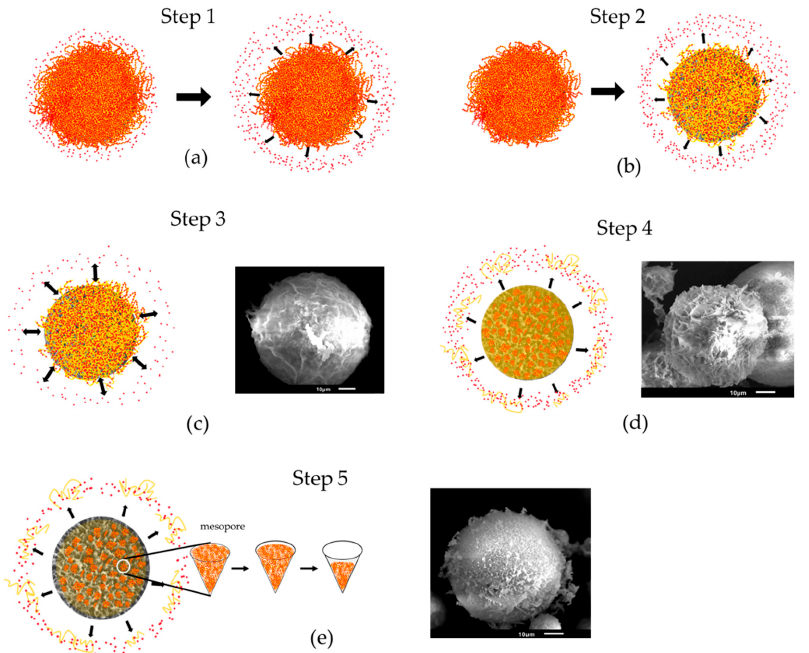
Figure 9. In vitro drug-release process illustrates five steps related to Figure 8, including ( a ) the dissolution of dried drug powders on the surface in step 1, ( b ) drug deboned from the surface